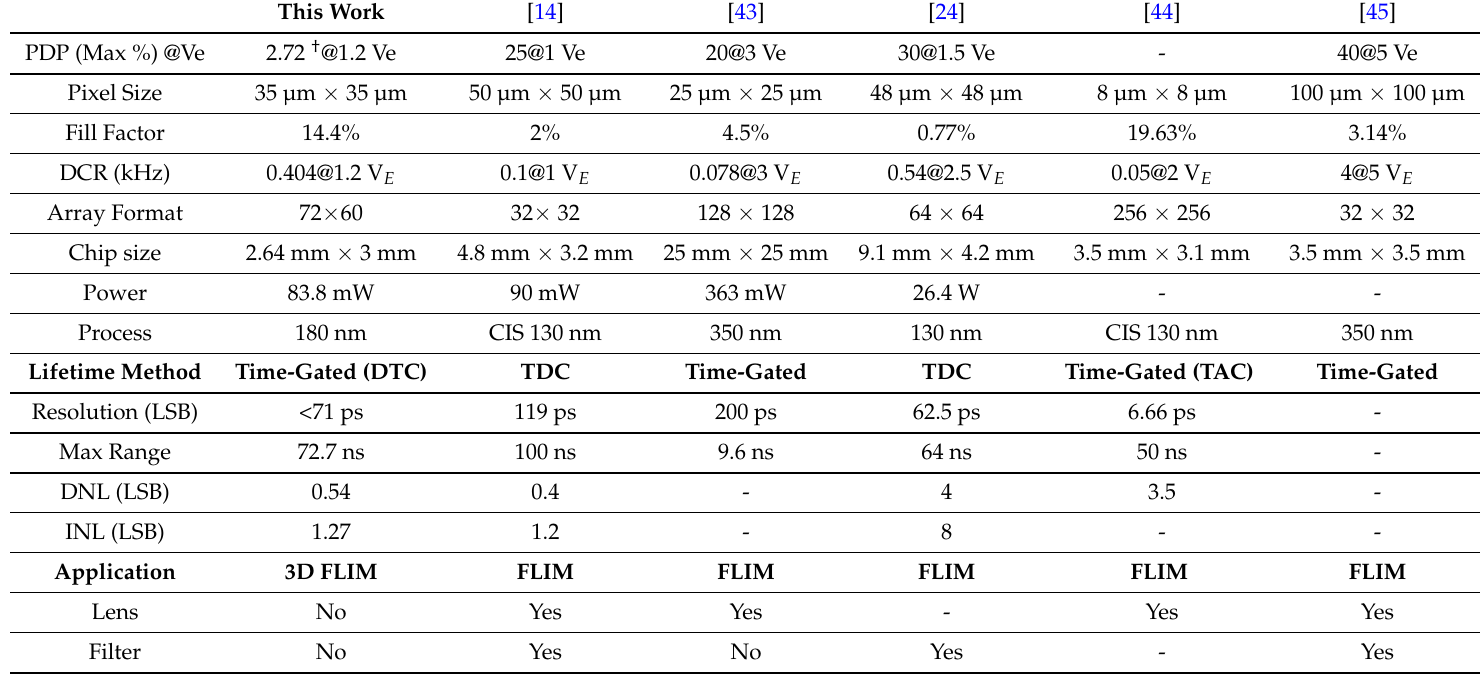
Table 1. Comparison with other state-of-the-art SPAD FLIM image